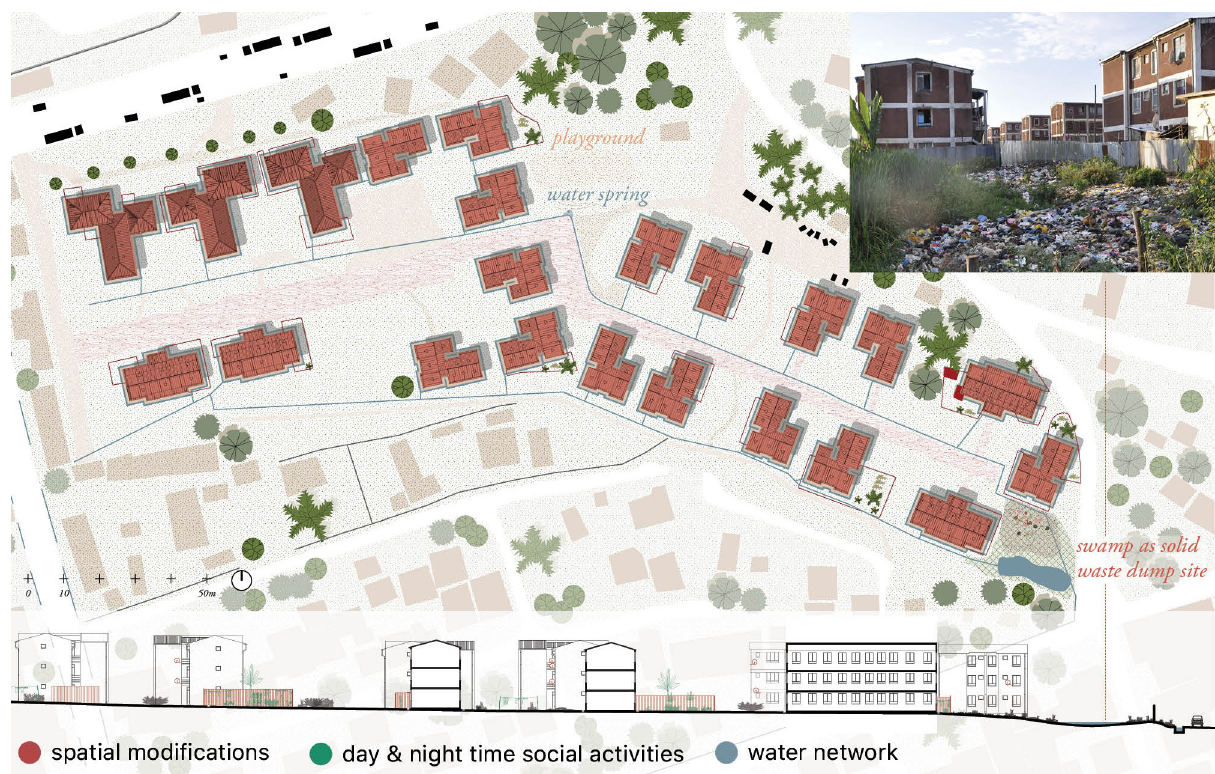
Fig 8. Waste management in Condominium A. The lowest point of condominium A is a swampy wetland, collecting rain, grey and black water. The area is used for waste collection, leading to a manyfold of potential mosquito breeding sites. The waste site collects all kinds of waste and is a habitat for chicken and cows. Next to this area, the excavation for the building site has cut through the ground water table, with a ‘fresh’ water spring as result. The spring is used for cleaning, washing, drinking and playing purposes. Graphic drawn by the authors, based on https://www.usgs.gov/ and openstreetmap.